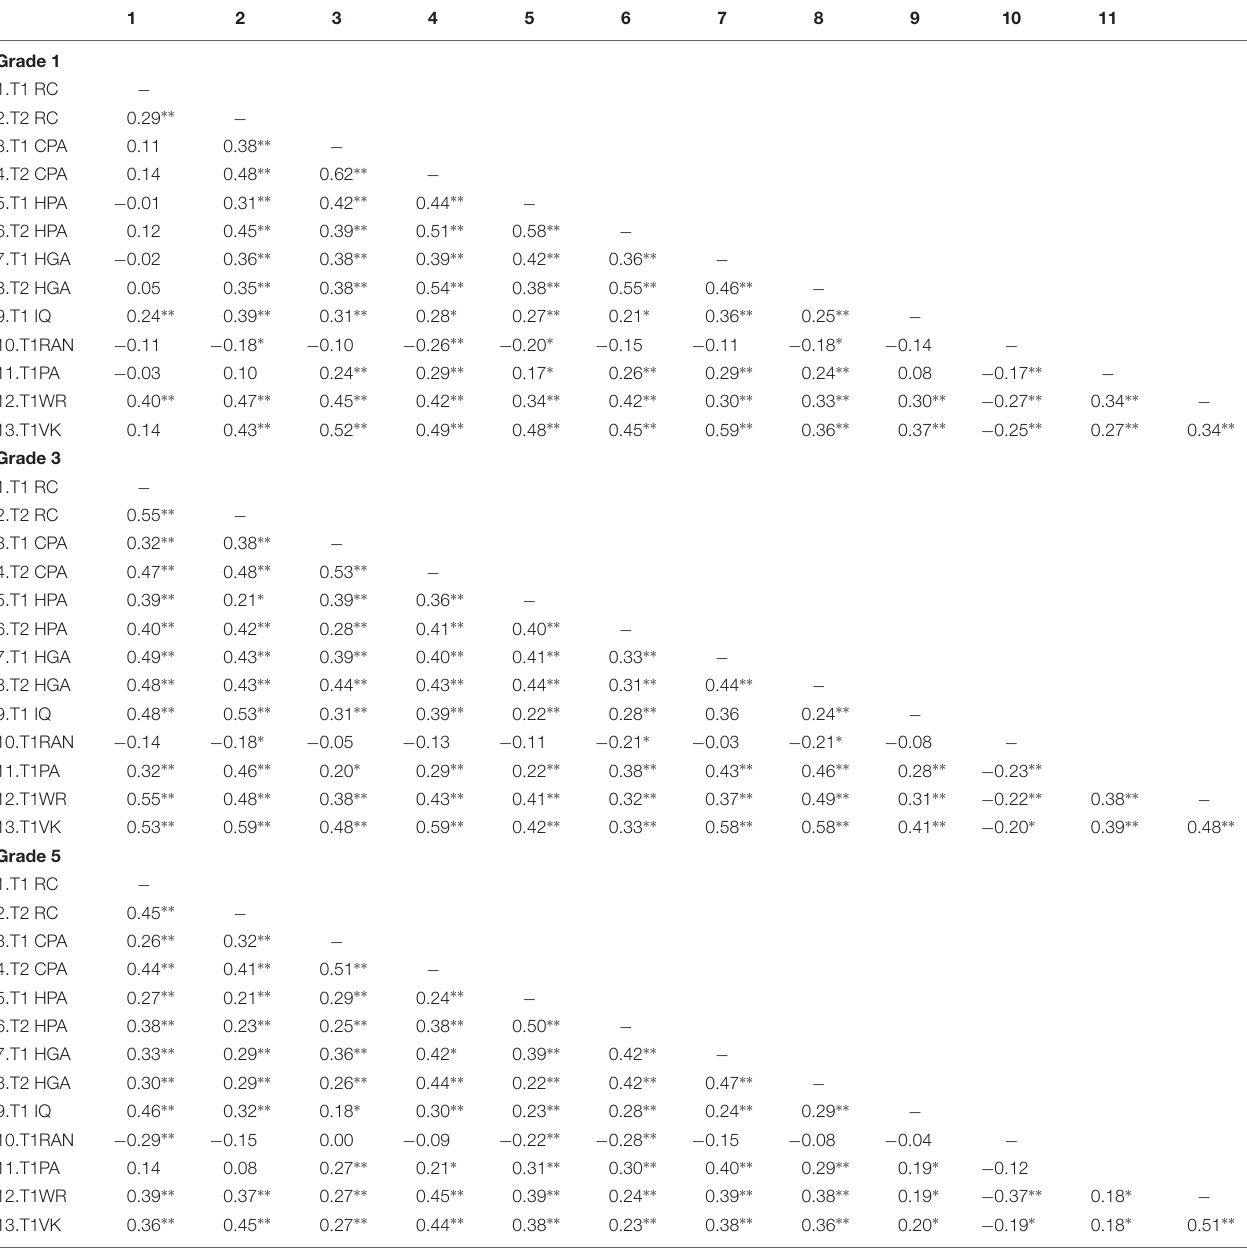
TABLE 2 | Pearson correlations between all variables among Grade 1, Grade 3, and Grade